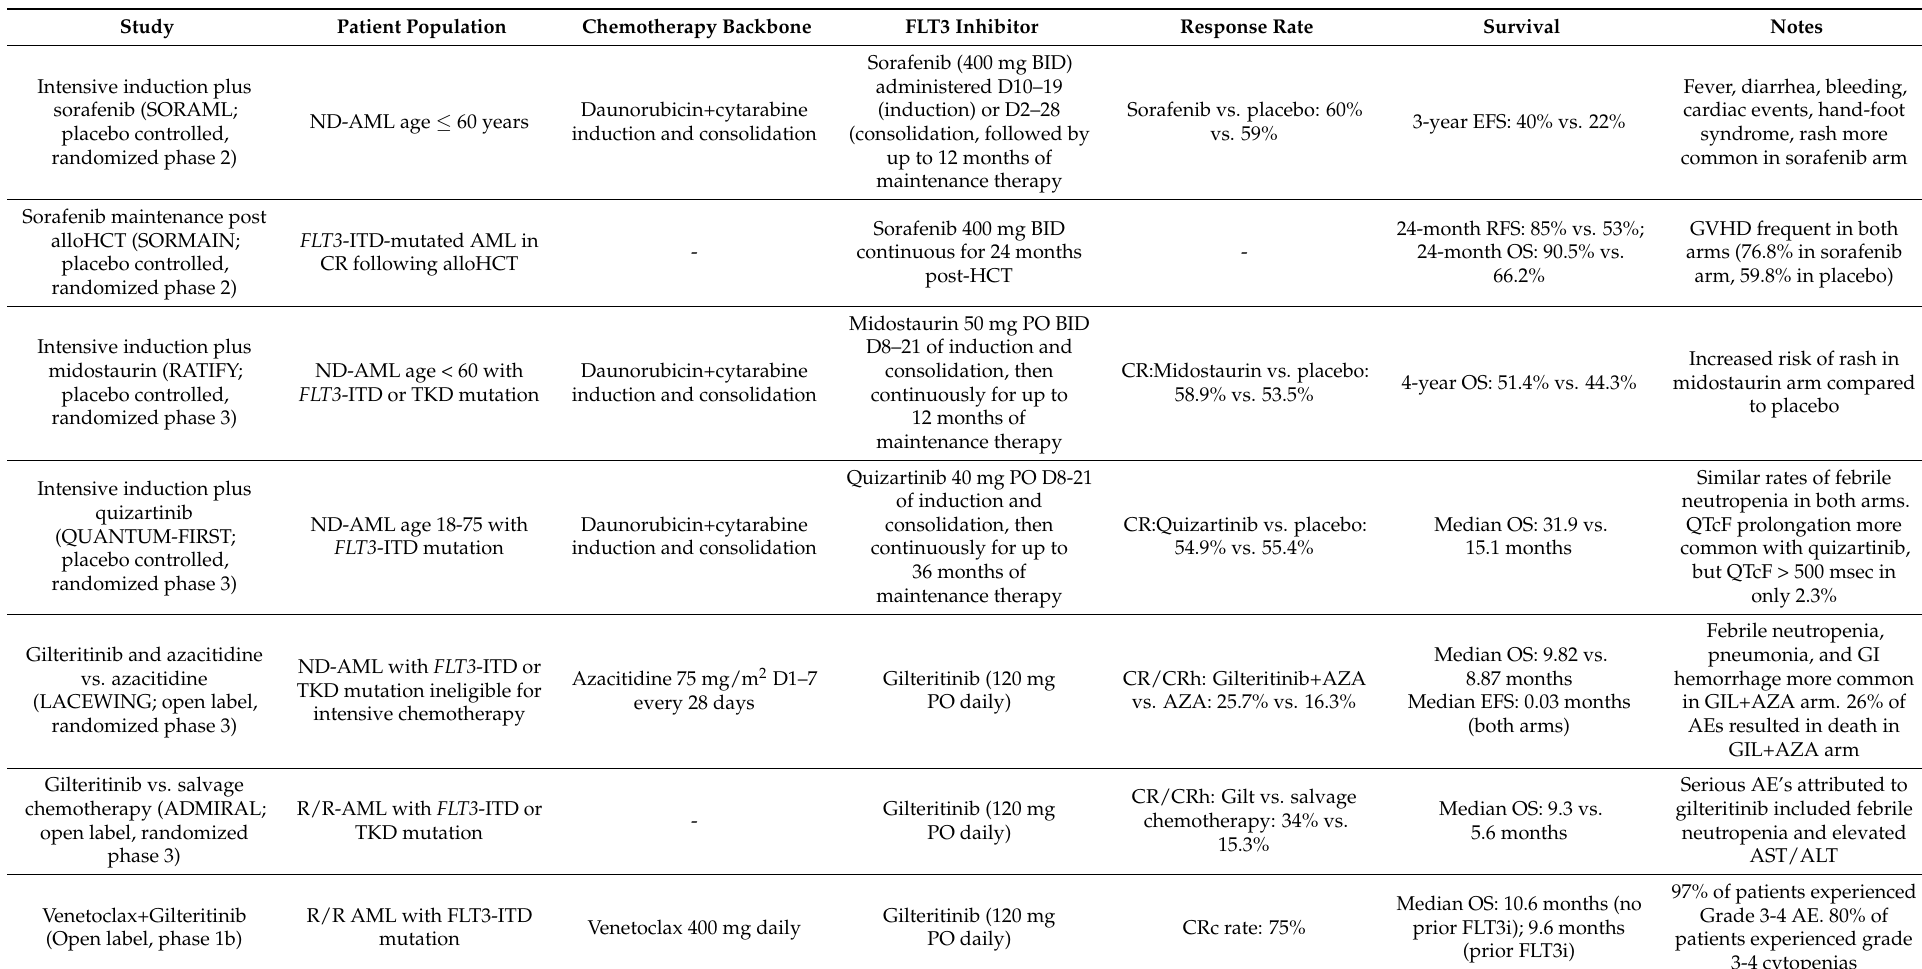
Table 1. Principal studies of FLT3 inhibitors for the treatment of